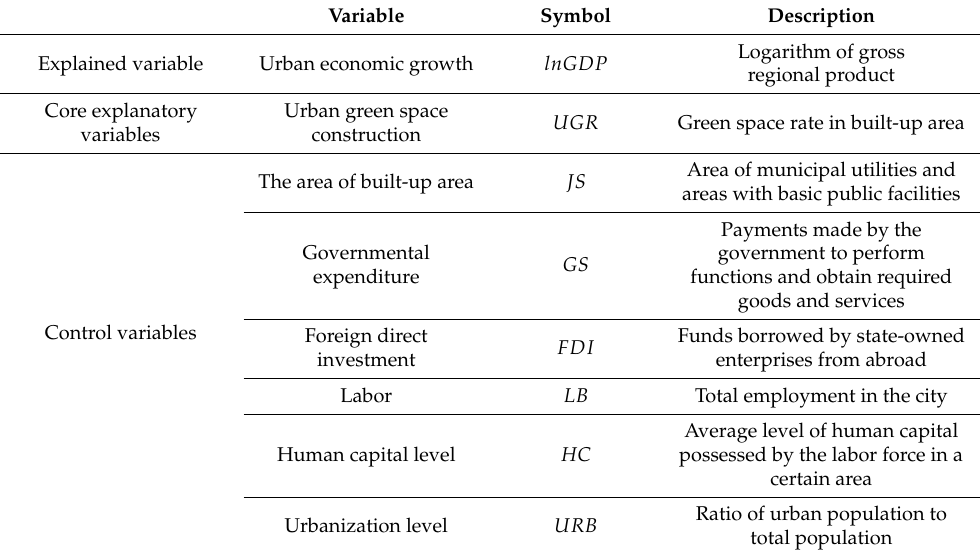
Table 1. Description of related